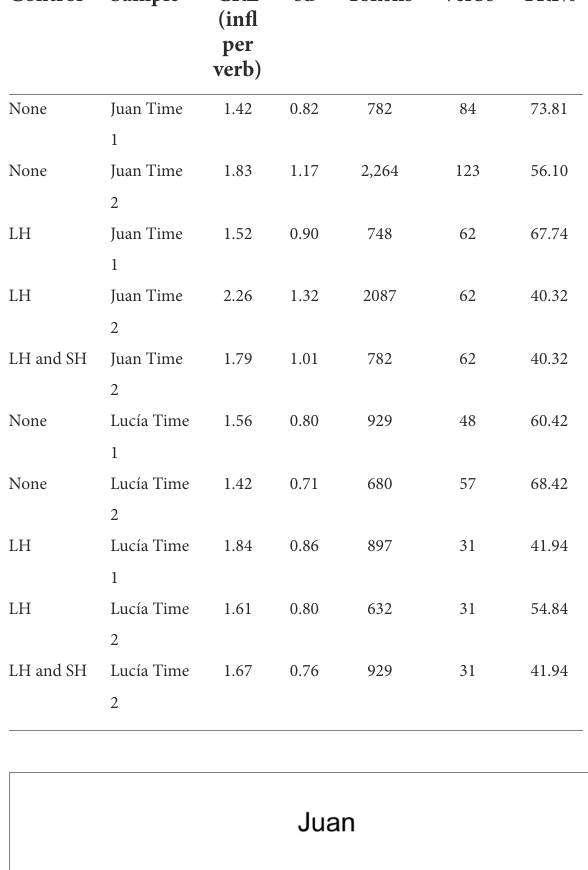
TABLE 5 Developmental analysis for the Spanish children.